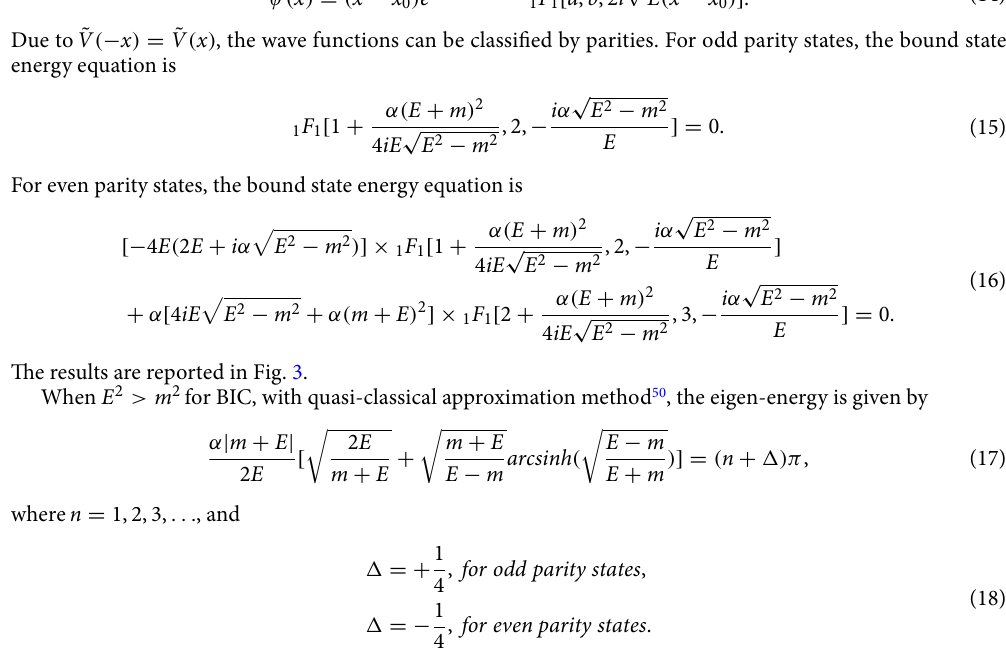
Figure 2. The effective potential wells surrounded by two infinitely high barriers (the red solid lines). ( a ): The effective potential for Coulomb potential ( α/ E > 0 ). The value of effective potential at x E ) 2 . ( b ): The effective potential for exponential potential. The value of effective potential at V ( 0 ) ( m ˜ = − + E ) 2 ( m x V ( 0 ) 0 , i.e., + 2 E ˜ = = V 0 − 1